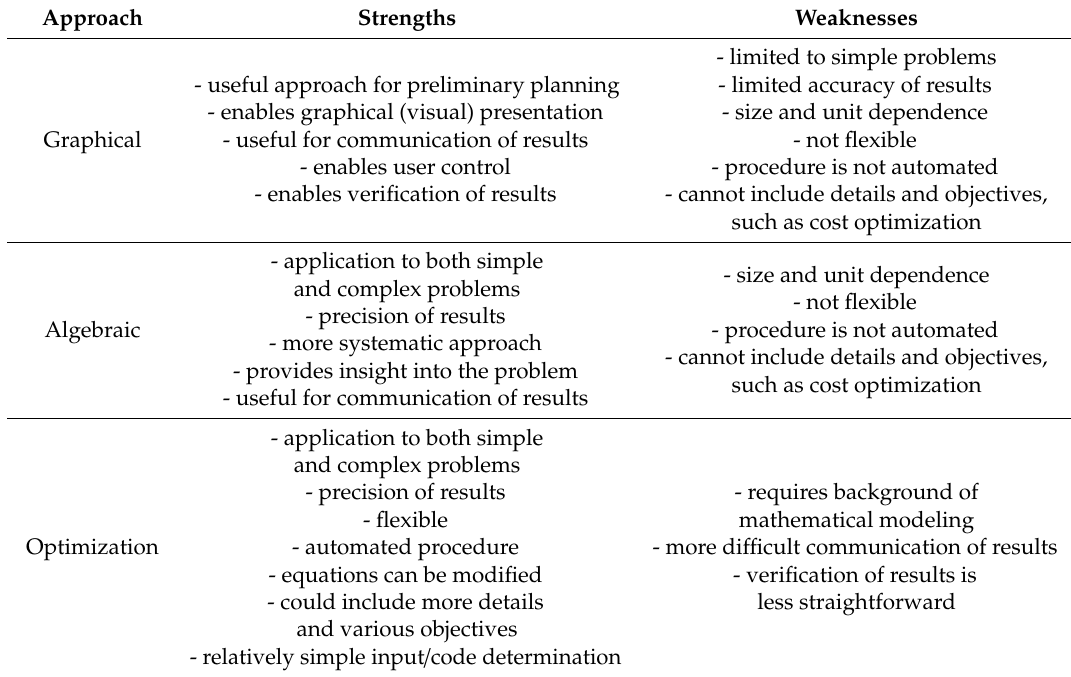
Table 8. Comparison of the